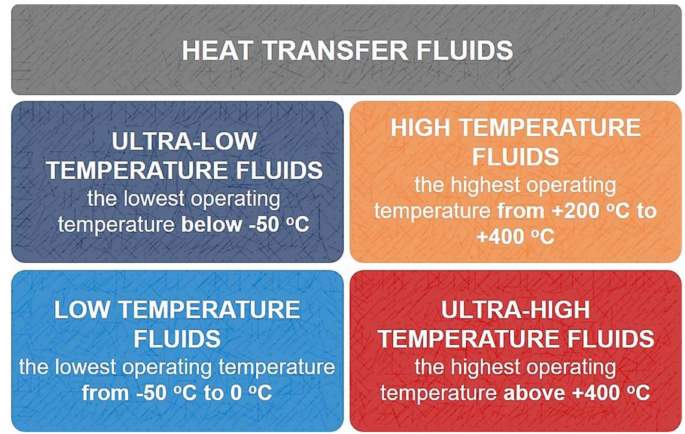
Figure 3. Basic categories of HTFs and their operating